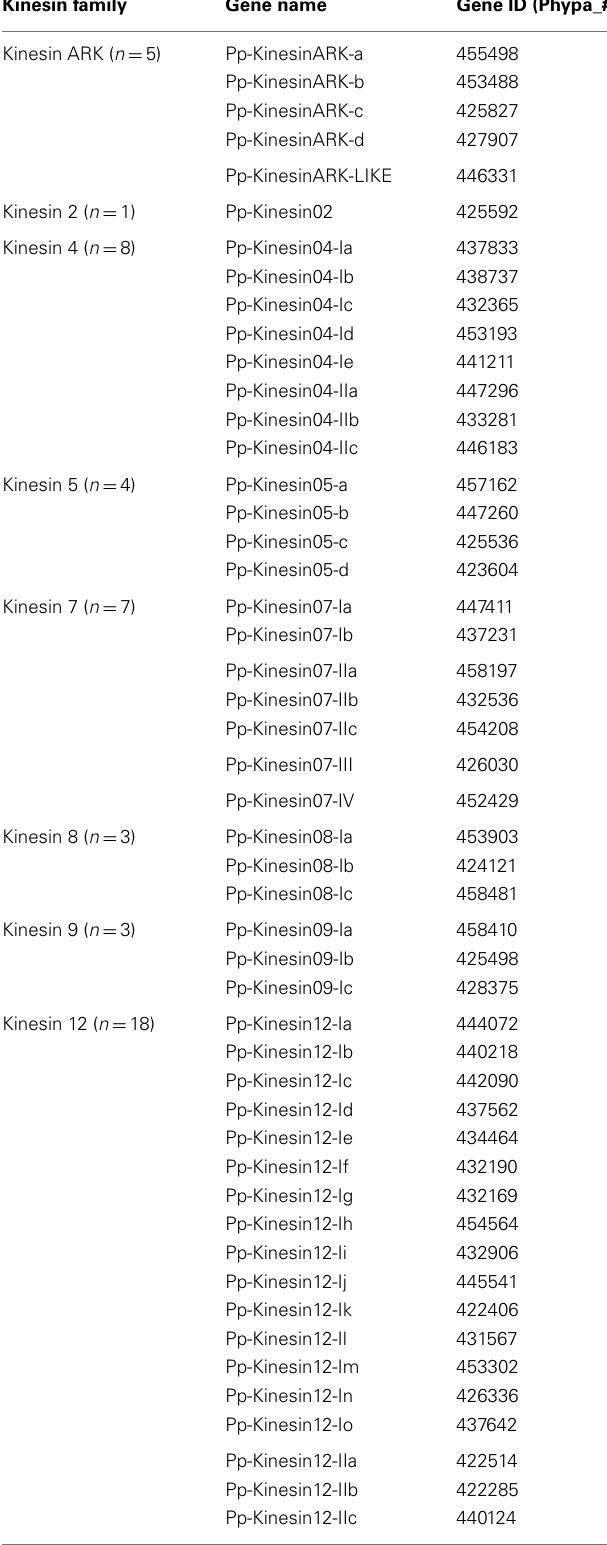
Table 1 | Kinesin families and classes in Physcomitrella patens